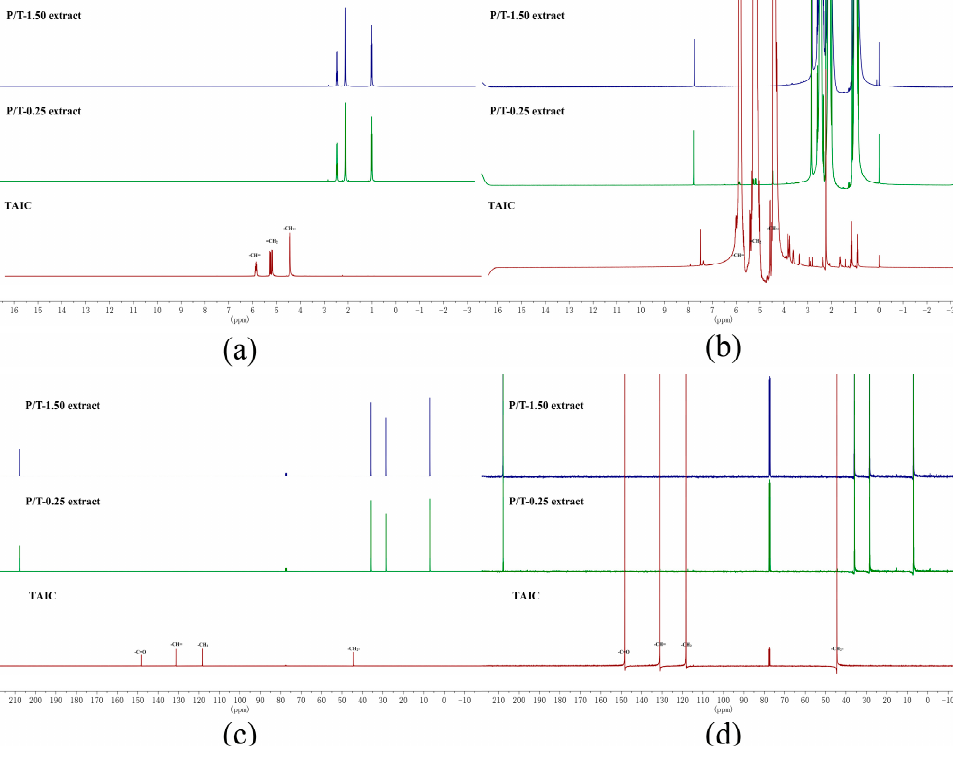
Figure 7. ( a , b ) 1 H-NMR spectra of different samples’ extractions; ( c , d ) 13 C-NMR spectra of different samples’ extractions. Table 4. Quantitative analysis results of different test methods.